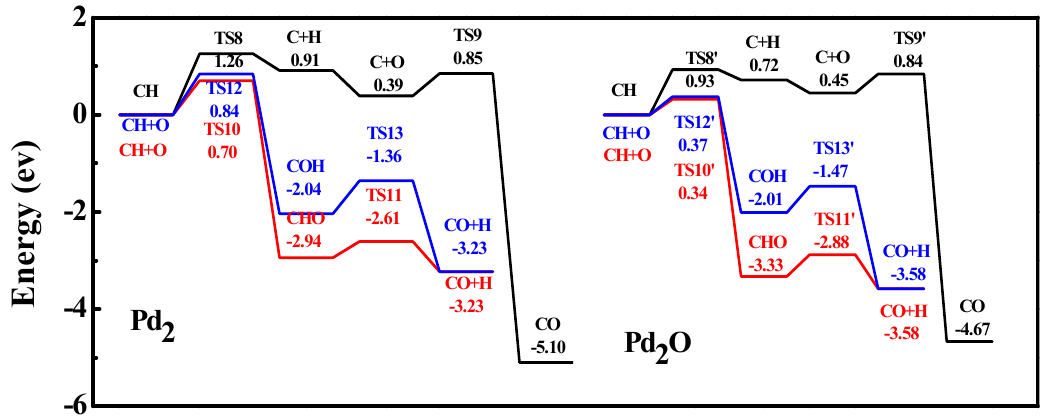
Figure 10. Energy profiles of carbon monoxide formation on Pd 2 and Pd 2 O. Left curve, three reaction paths on Pd 2 ; right curve, three reaction paths on Pd 2 O.